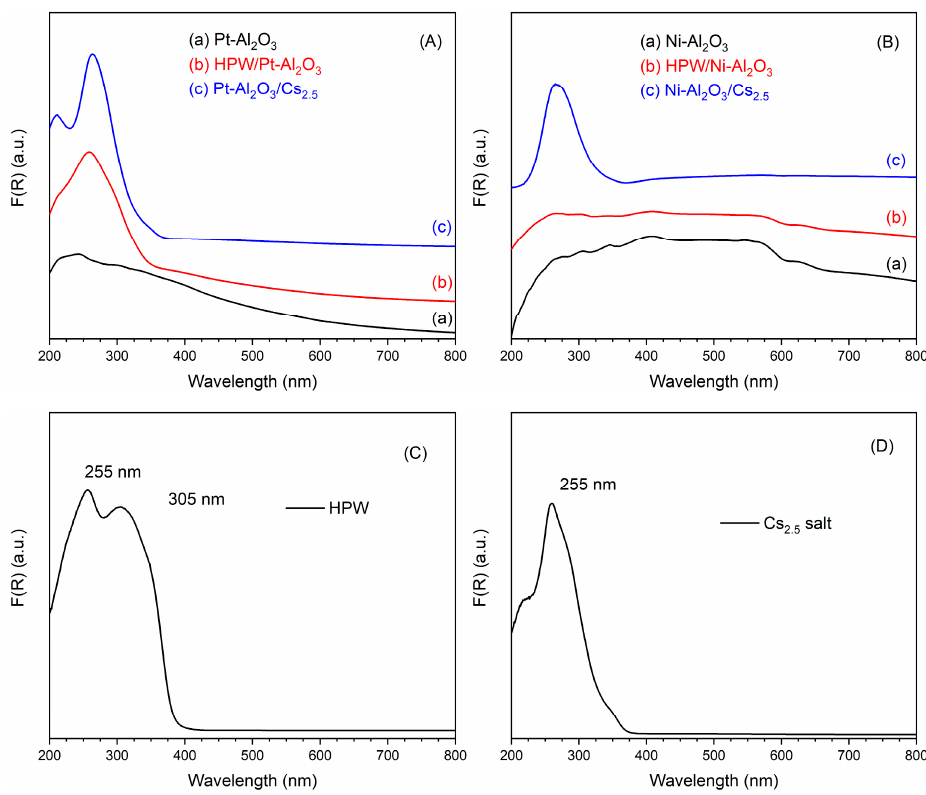
Figure 4. UV-Vis DRS spectra of the different catalysts: ( A ) Pt-Al 2 O 3 series; ( B ) Ni-Al 2 O 3 series; ( C ) HPW; ( D ) Cs 2.5 salt.